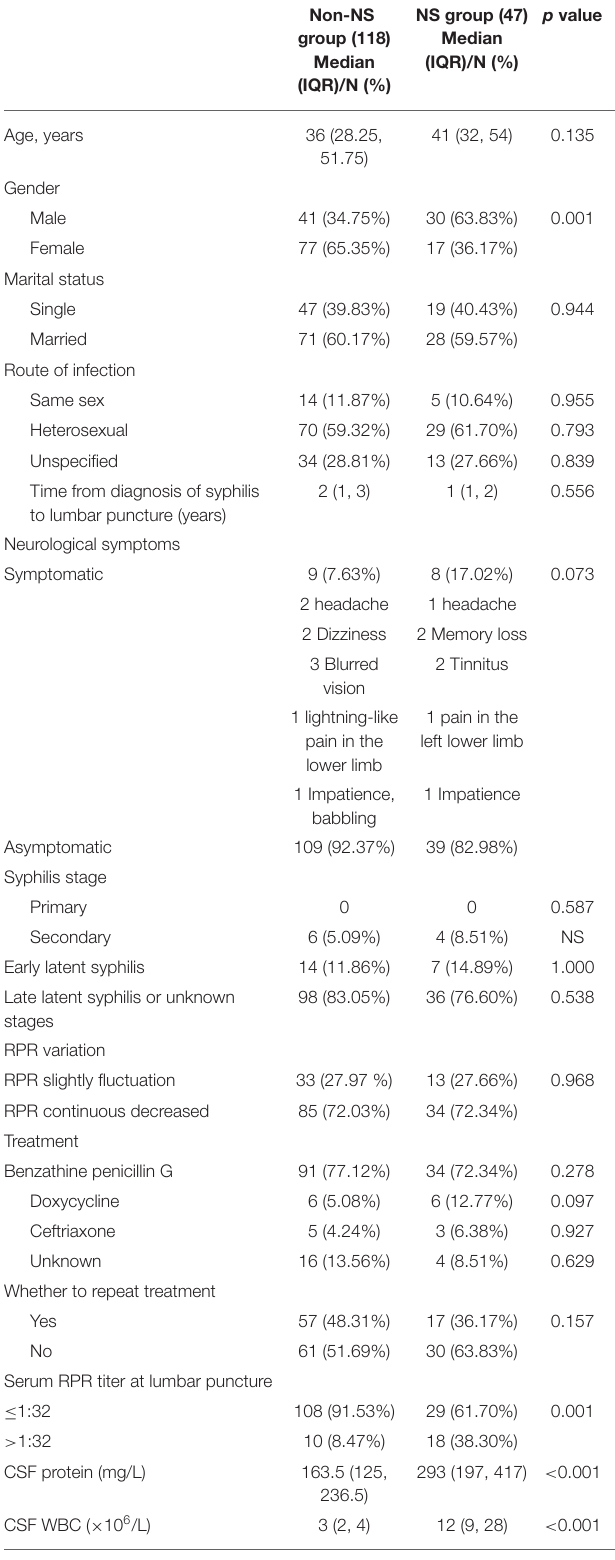
TABLE 1 | Demographic and clinical characteristics of the included patients. TABLE 2 | Logistics regression analysis of factors related to neurosyphilis